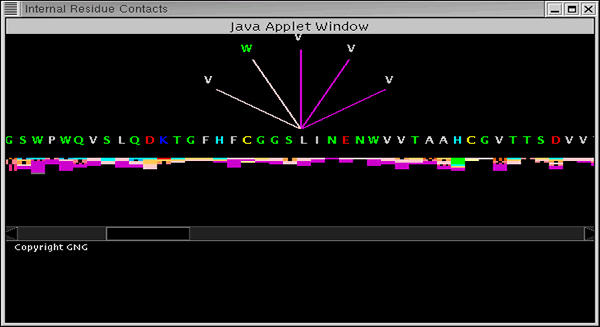
Atomic contacts among residues within same chain. Internal residue contacts formed by the Leu_46, showing all amino acids, belonging to the same chain E, that make contacts with it. The fan above the residue is color coded according to the type of contact the residue is involved with.